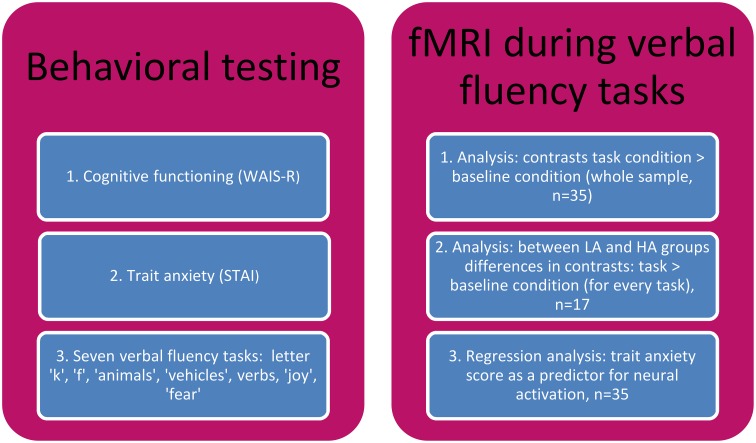
The study outline.